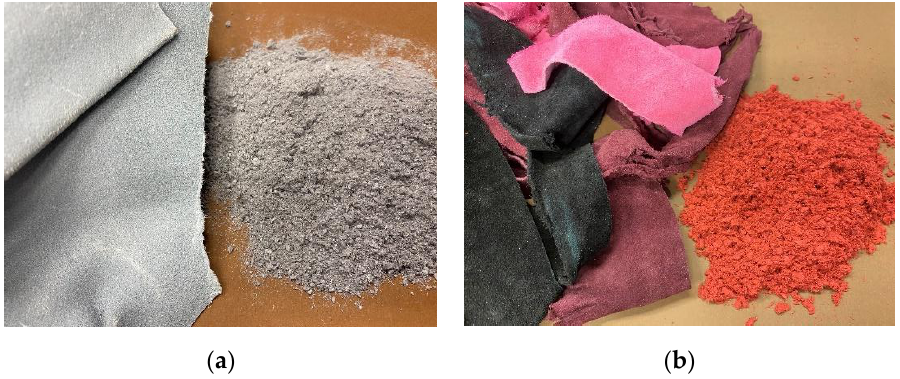
Figure 4. Physical aspect of: ( a ) wet blue; ( b ) finished leather scraps, before and after grinding.